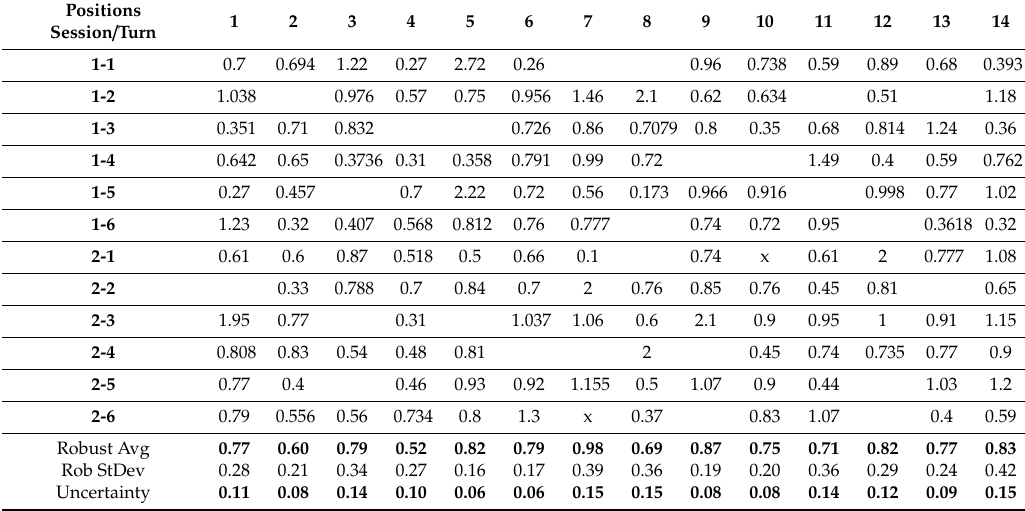
Table 2. Measurement samples in CP mode for all positions with their average values, standard deviation, and